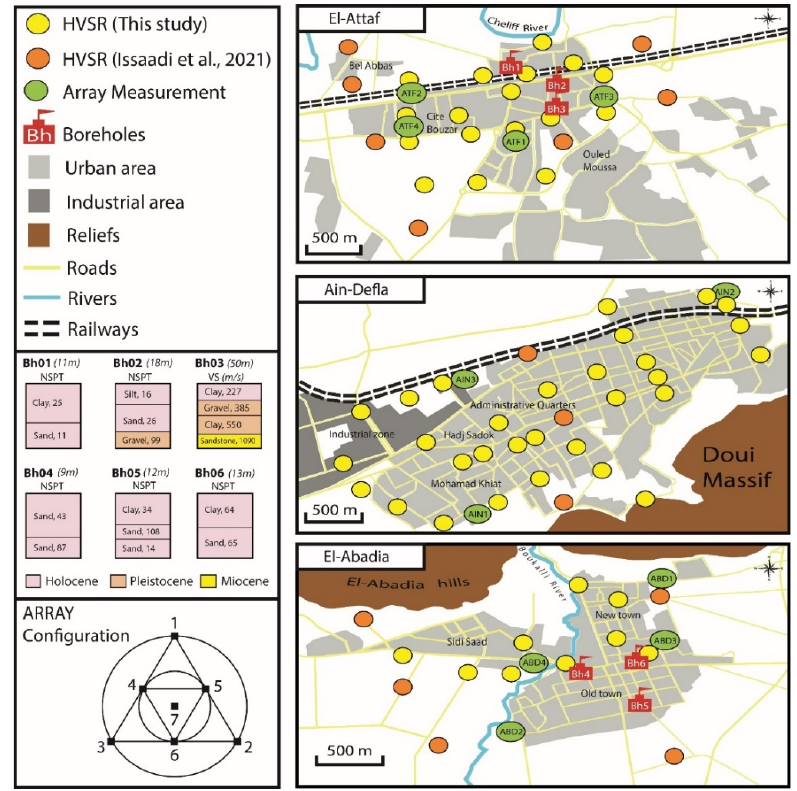
Figure 3. Distribution of the data compiled in this study. The orange circles correspond to data mea- sured in [21]. The left panels correspond to the legend, the borehole data, and the array configuration, from top to bottom, respectively. Bh03 was taken from [14]. The rest was taken from [15].